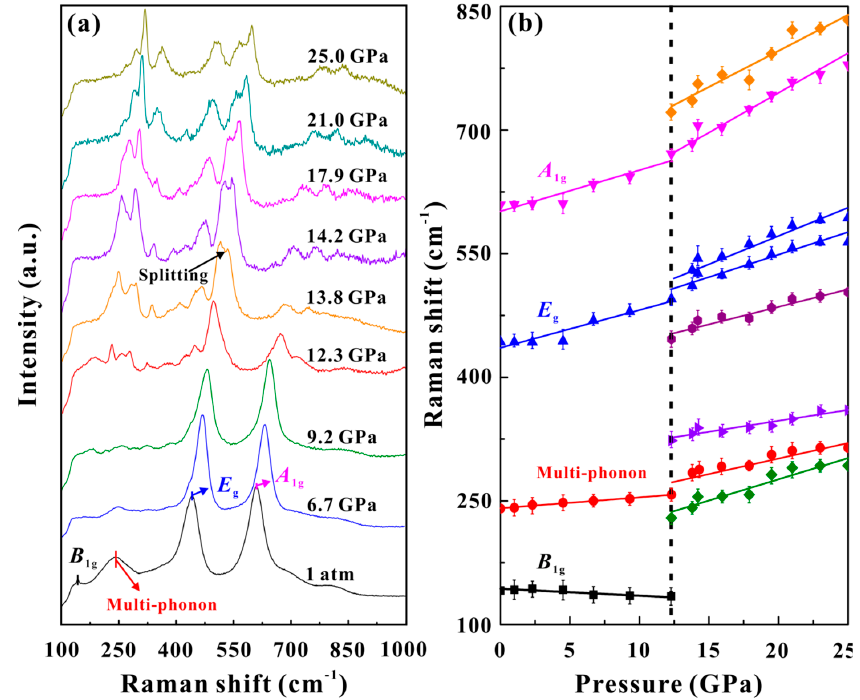
Figure 2. ( a ) Raman spectra of nanocrystalline rutile at representative pressures during compression process. ( b ) The evolution of the Raman shift with increasing pressure (d v /d P ) at atmospheric temperature.